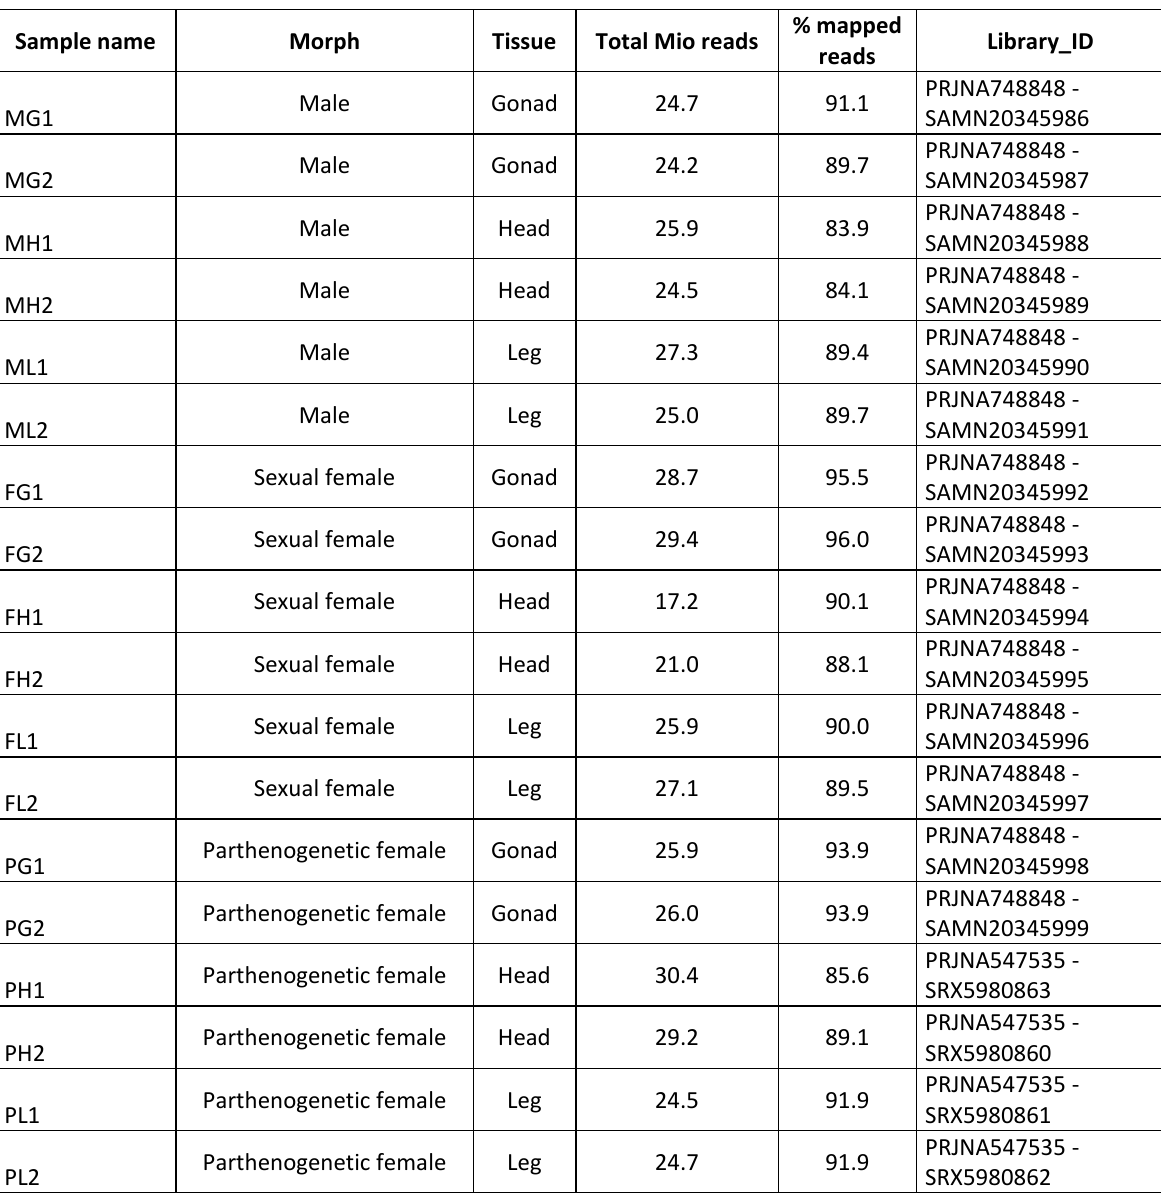
Supplementary table S1: The different RNA sequencing libraries used in the present